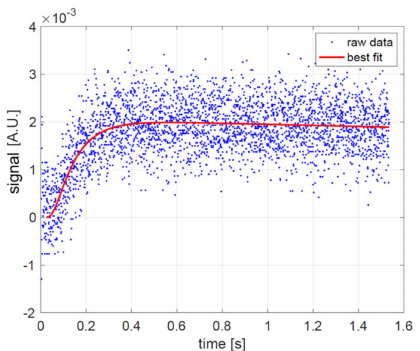
Figure 1. Results of the AISI 304 specimen measurements given as an example of the raw output. Experimental data and fitting curve for the average of 100 shots